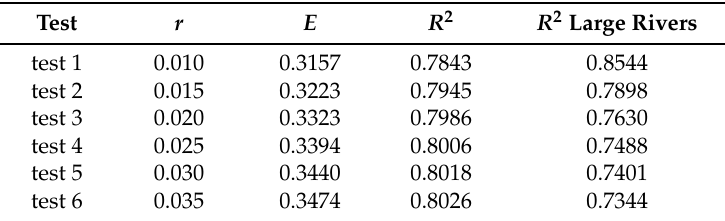
Table 2. Sensitivity analysis of the vegetation growth rate r